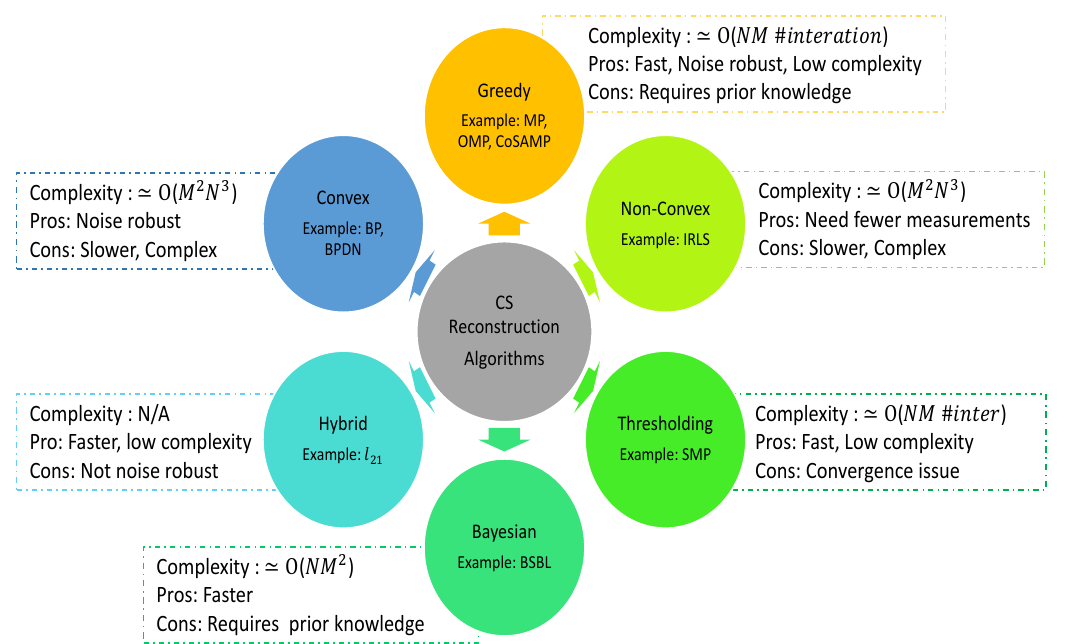
Figure 3. Classification of reconstruction